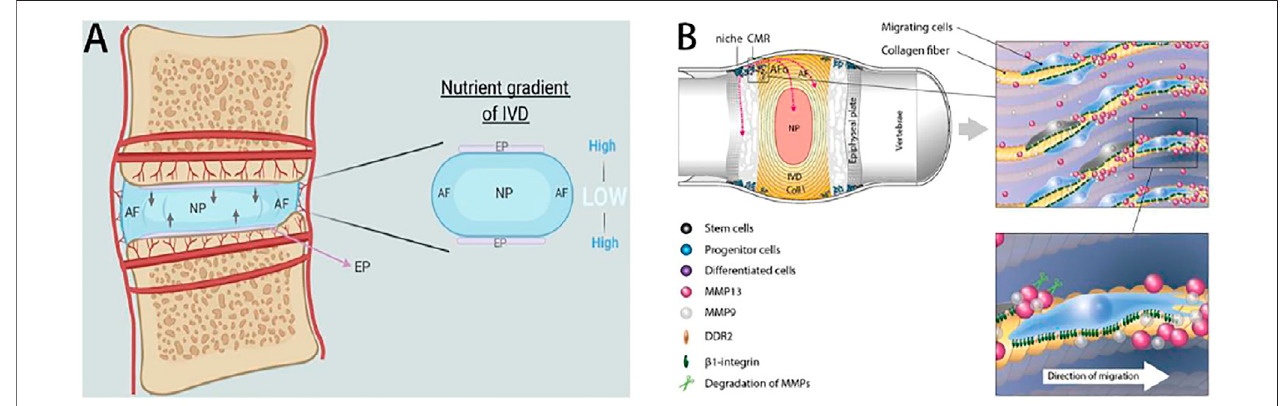
FIGURE1| OverviewofIVDsstructureandthecellularmigration/directionsduringIVDsrepair. (A) AvascularnatureofthehumanIVDs.ReproducedfromRebecca etal.(Kritschiletal.,2021)withpermission fromCopyright2021Wiley. (B) Intervertebral discstemcellnicheandcellsmigrate toAF,theouterlayerofcollagen-rich fi bers (COLLI).CellsmigratetothegerminalregionandinteractwithECMalongthealignmentofcollagen fi bers.Moreover,thedisorganizationofcollagen fi bersandincreasing of the interlamellar distances between collagen bundles in the annulus fi brosus were usually observed during the degeneration process that often results in disc bulging. Reproduced from Henriksson et al. (2015) with permission from Copyright 2015